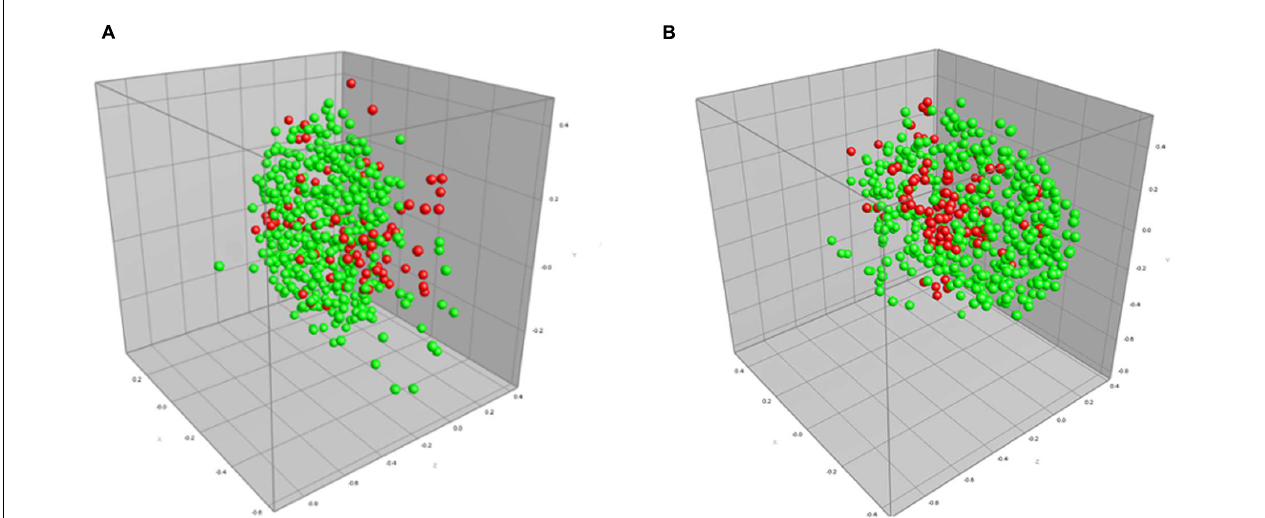
FIGURE 2 | Multidimensional scaling (MDS) representation of MALDI-TOF mass spectra of 172 isolates (516 spectra) of beta-lactam resistant (red) and sensitive (green) strains of C. jejuni using (A) default spectrum processing settings and (B) optimized processing settings defined in the designed experiments approach in this study. The ranked Pearson correlation coefficient was used to quantify similarity in both the default and optimized